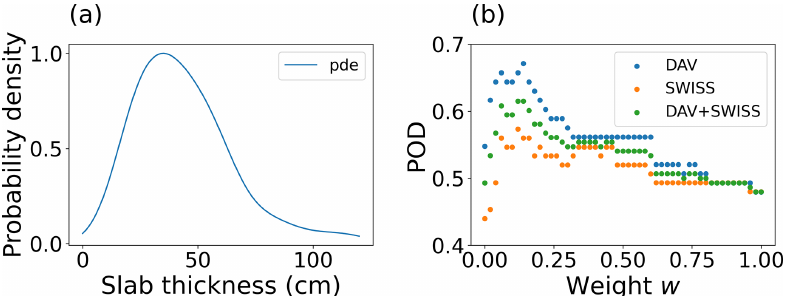
Figure 12. (a) Normalized Gaussian kernel density estimate (pde) for the distribution of observed slab thicknesses in the unstable class of the DAV data set. (b) Probability of detecting the manually picked weak layer in dependence on the weighting factor w used in the calculation (w) (Eq. 9) for the unstable classes in the DAV data set (blue markers), in the SWISS data set (orange markers) and in the of P ∗ unstable combination of both (green markers).